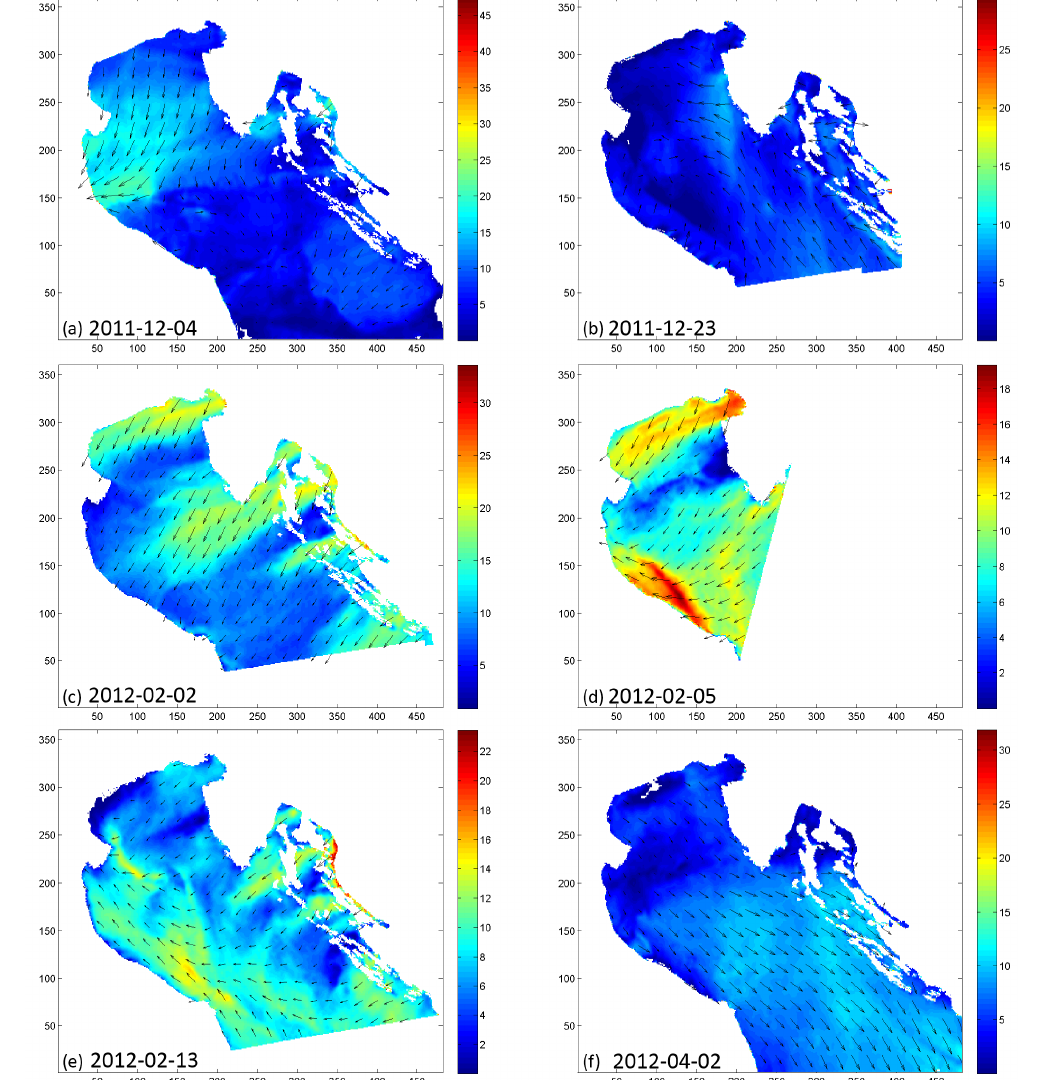
Figure 2. Some of the 15 SAR wind fields available for wave